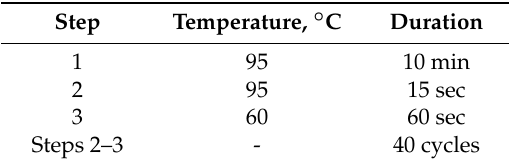
Table 2. Thermocycling program for quantitative polymerase chain